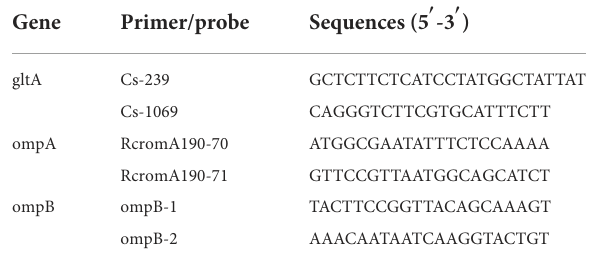
TABLE 2 Primers used in the